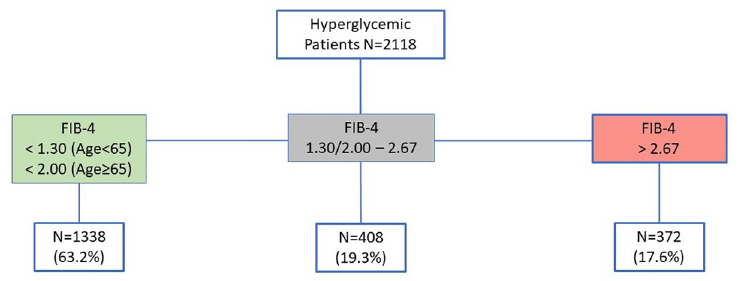
Fig 2. Flowchart of hyperglycemic